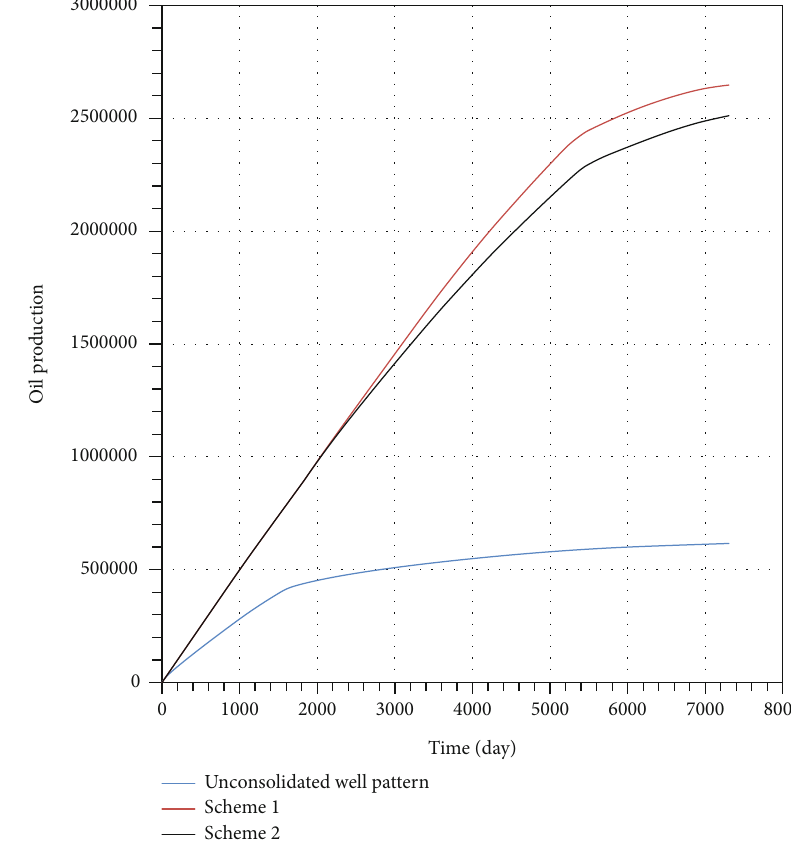
Figure 15: The relationship between production time and RF. Table 1: Economic evaluation